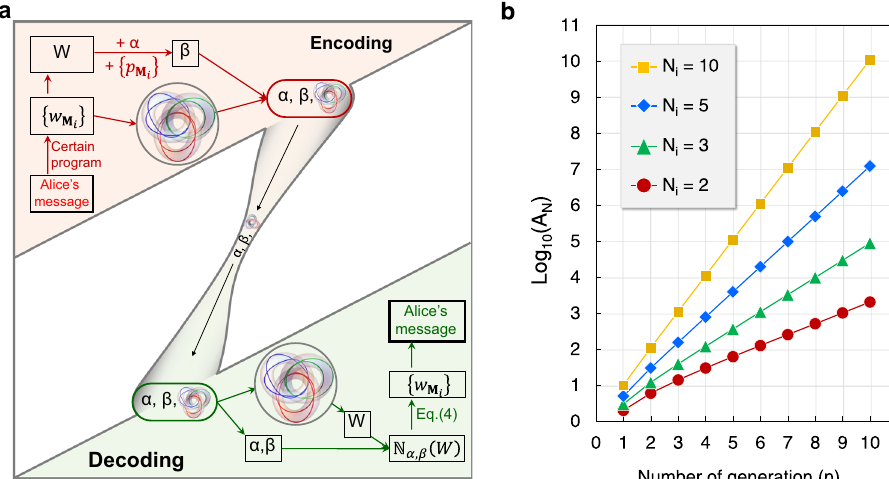
Fig. 2 Schematic diagram of the communication protocol based on the nested knotted structure and its capacity. a A communication protocol between Alice (sender) and Bob (receiver). In Alice ’ s encoding part, Alice converts her message into a set of numbers f w M g by using a certain program. She i calculates the W with f w M g , obtains β with Eq. (3) by choosing a positive integer α and prime numbers f p M g . On the other hand, she generates a nested (cid:6) (cid:7) i i knotted structure ( N k ), whose set of winding numbers is exactly the f w M g . Then, Alice sends the pair of numbers α ; β and the N k to Bob in real time. In i Bob ’ s decoding part, after receiving these, Bob computes N α ; β W ð Þ with its de fi nition, decodes the f w M g by using prime factorization as Eq. (4), and obtains i Alice ’ s message. b The relationship between the total number of the winding number ( A N ) and the number of generations ( n ). Here, we set the number of strands in each braid to 2, 3, 5, or 10. That is, N i ¼ 2, 3, 5, or 10. A N increases exponentially with the increase of n , and A N also increases rapidly with the increase of N i